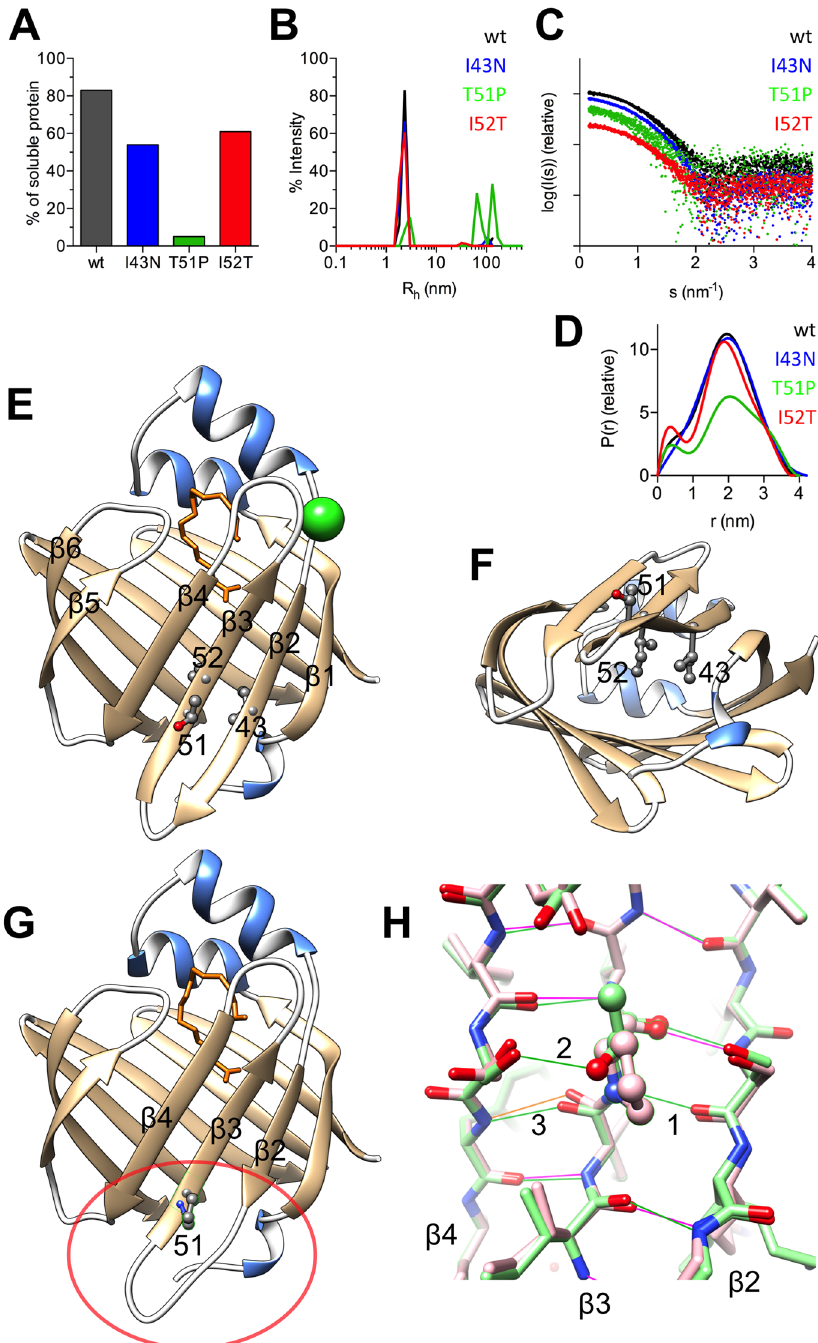
Figure 1. Structure and stability of P2. ( A ) Solubility analysis. ( B ) Dynamic light scattering indicates aggregation of T51P. Note that the curves for P2wt and I43N nearly overlap in panels B and D. ( C ) The SAXS scattering curve. ( D ) Distance distribution functions. ( E ) Crystal structure of P2 with the mutant positions labelled. The bound fatty acid is shown in orange and the anion binding site with a chloride ion (green). ( F ) The mutation hot spot viewed from the bottom. ( G ) The crystal structure of T51P. Note the decreased area of the β sheet close to the mutation; compare the circled area with the corresponding area in panel E. ( H ) Hydrogen bonds near residue 51 in wild-type (green) and T51P (pink); the shown region corresponds to the circled area in panel G. Three hydrogen bonds are labeled: 1) main-chain H bond that is lost in the mutant protein, 2) side- chain hydrogen bond lost in the mutant protein, 3) main-chain H bond that is in an unfavorable conformation in the mutant protein